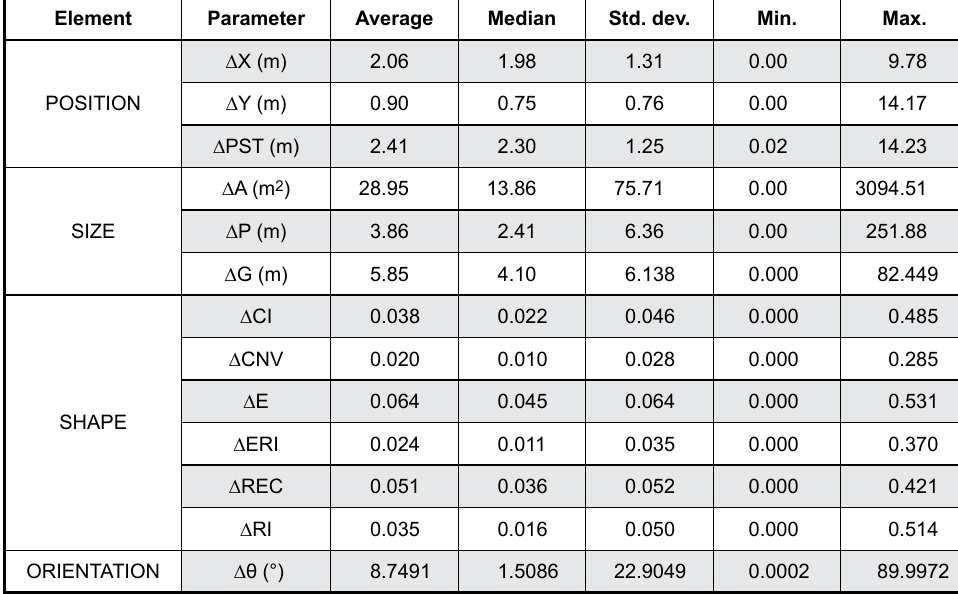
Table 4. Difference statistics of the parameter values